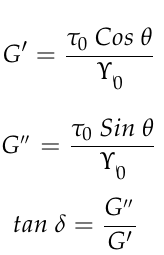
Table 3. Summary of the utilization of legumes and pulses in bread baking and pastry